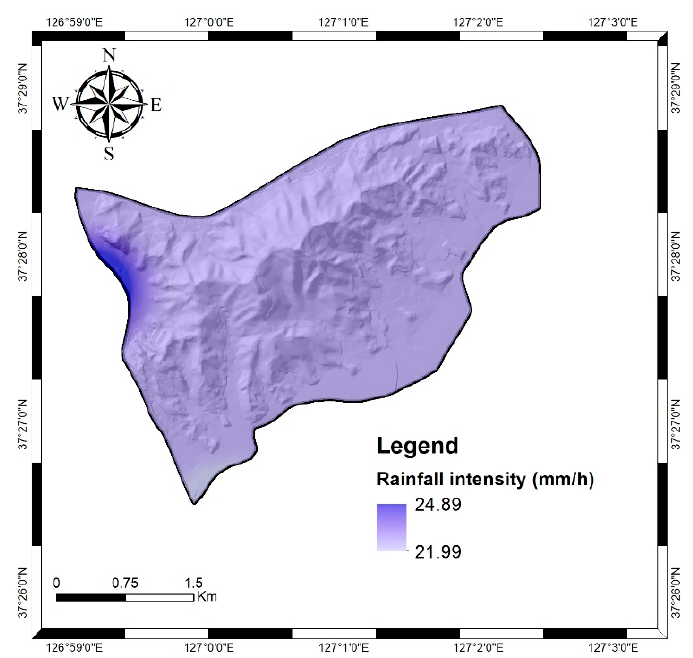
Figure 7. Map showing rainfall intensity using kriging interpolation based on automatic weather system observatory locations.